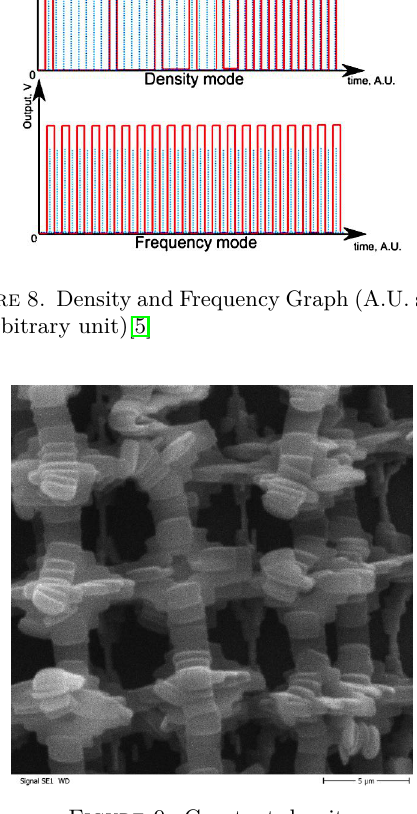
Figure 9. Constant